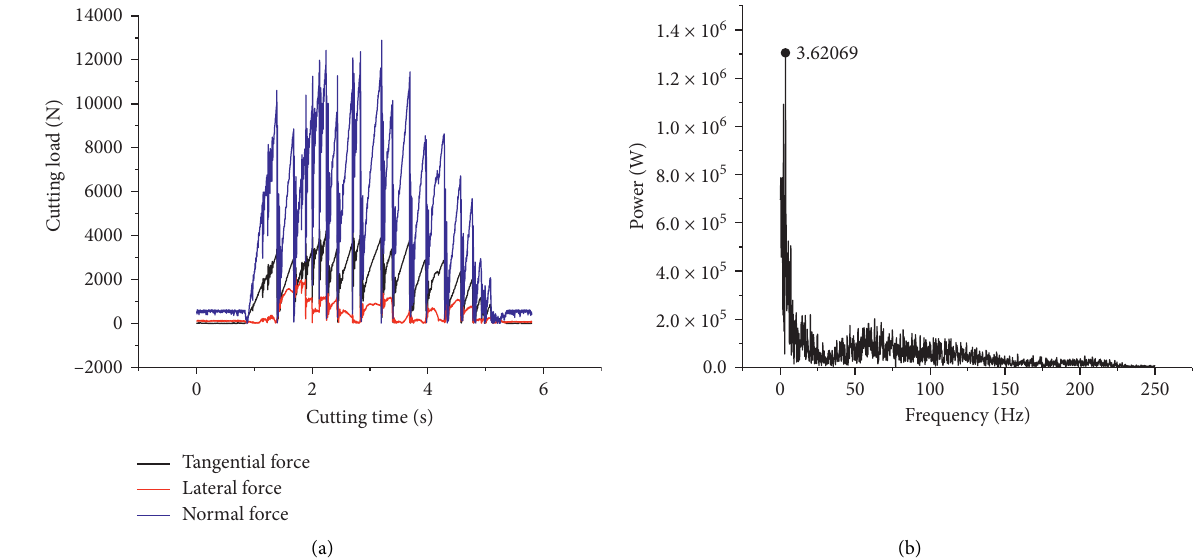
Figure 3: Time domain (a) and frequency domain (b) of cutting